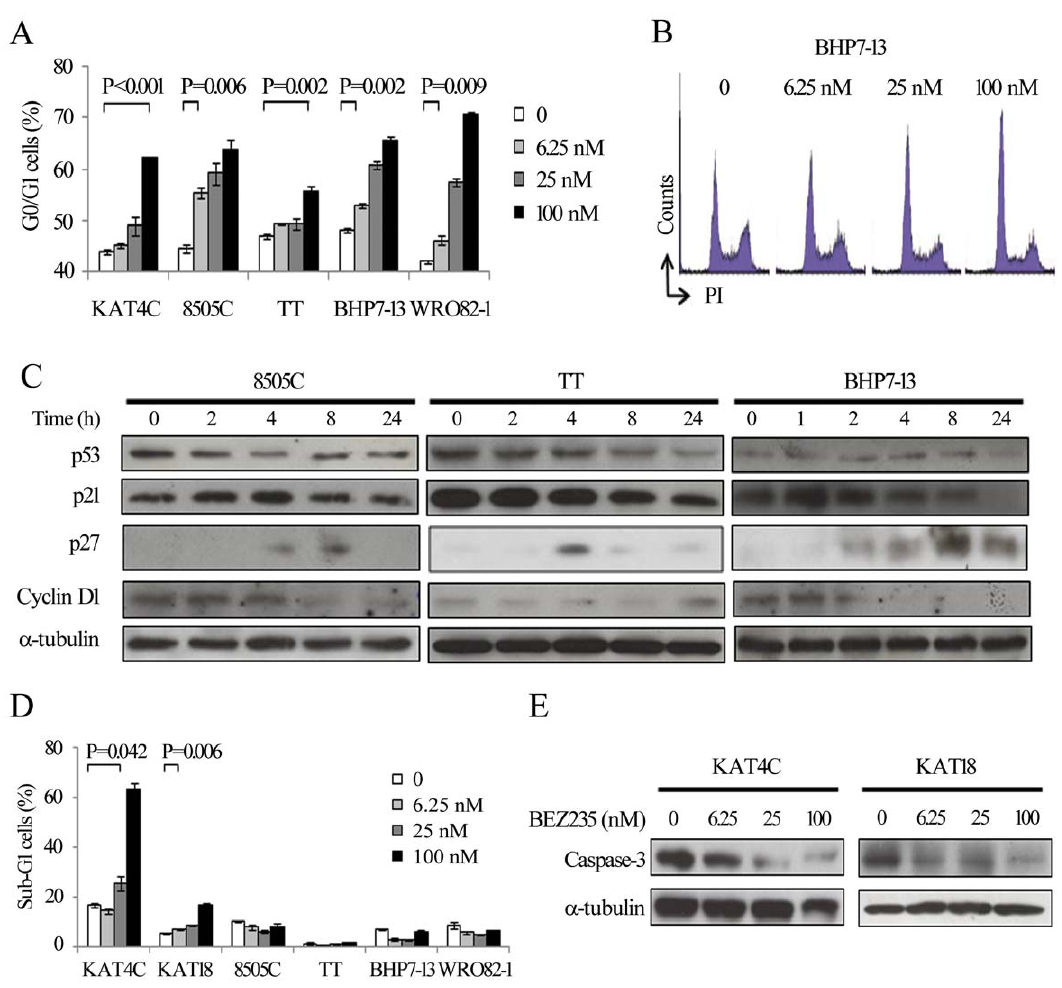
Figure 3. BEZ235 inhibits cell cycle progression at G0/G1 phase, and induces apoptosis in KAT4C and KAT18. A, analysis of cell cycle by measurements of DNA content revealed increasing doses of BEZ235 accumulates cells at G0/G1 by 24 hours (KAT4C, 8505C, BHP7-13 and WRO82-1) and 72 hours (TT). B, a representative cell line, BHP7-13 demonstrated cell cycle arrest at G0/G1 phase. C, cell cycle regulating proteins were evaluated using immunoblot in cells treated with BEZ235 at 100 nmol/L. p53 was decreased by 2 to 4 hours in 8505C and TT. BEZ235 gradually reduced p21 in TT and BHP7-13. p27 was increased in all cell lines. Cyclin D1 gradually decreased in 8505C and BHP7-13. D, apoptosis measured by flow cytometry to measure sub-G1 cells revealed that BEZ235 increases proportions of sub-G1 cells in KAT4C and KAT18 at 96 hours. E, immunoblot showed BEZ235 induced degradation of executioner caspase-3 in KAT4C and KAT18.